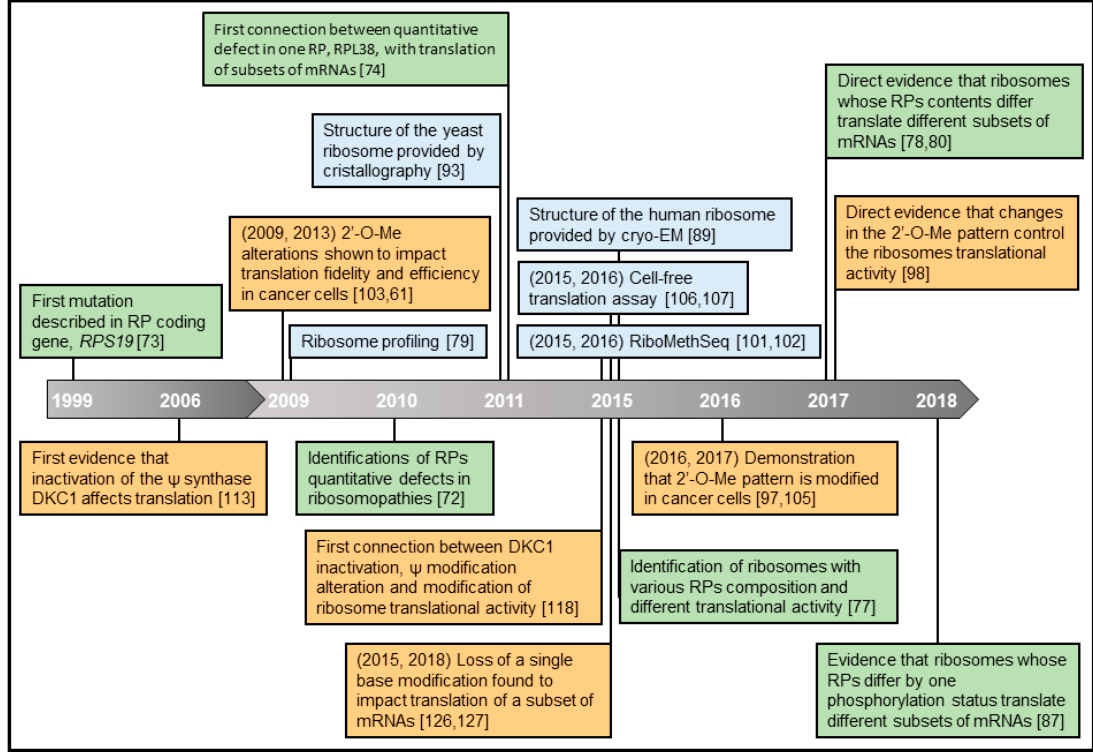
Figure 2. Key manuscripts and associated breakthrough technologies that contributed to demonstrating that a specific ribosome composition determines the subset of mRNAs being translated. First and second decades, 1999–2008 and 2009–2018, are depicted by two grey arrays. Hallmarks colors are as follows: impact of RP defects (green) and rRNA modifications (orange) on ribosome translational activity, as well as breakthrough technologies and ribosome structure provided by recently developed structural technologies (blue).